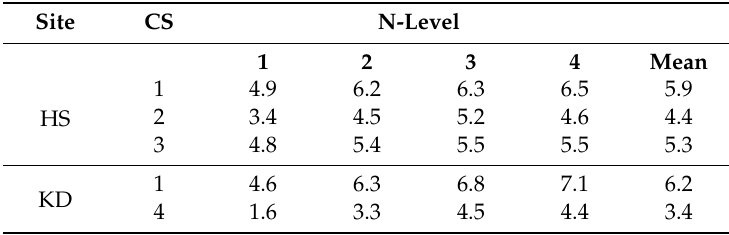
Table 9. Transpiration use efficiency (g mm − 1 ) of the cropping systems (CS) in Hohenschulen (HS) and Karkendamm (KD), separated between